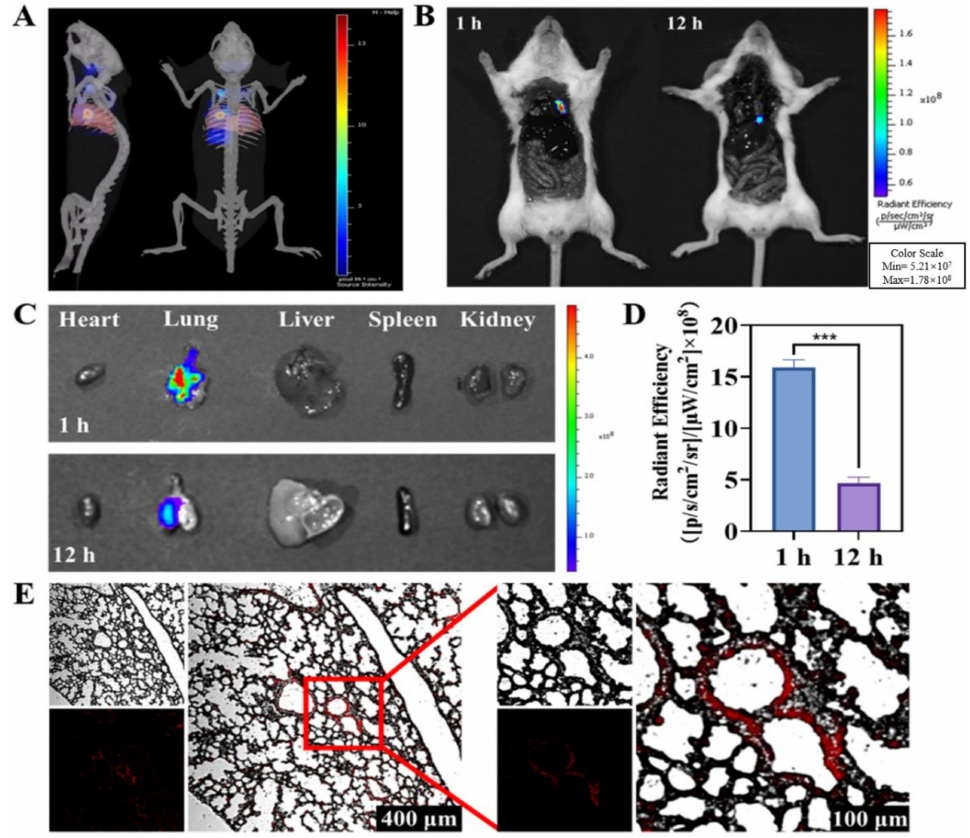
Figure 2. PM2.5 biodistribution in vivo. ( A ) Three-dimensional fluorescence imaging after PM2.5 installation for 12 h in mice. ( B ) Anatomical imaging 1 h and 12 h post-PM2.5 exposure. ( C ) Distribu- tion of PM2.5 fluorescence in different organs including the heart, lung, liver, spleen, and kidneys. ( D ) PM2.5 fluorescence intensity quantification in lung tissues. ( E ) Upper left panel: bright field; lower left panel: fluorescent field; right panel: merge. Data are expressed as mean ± SD. *** p <